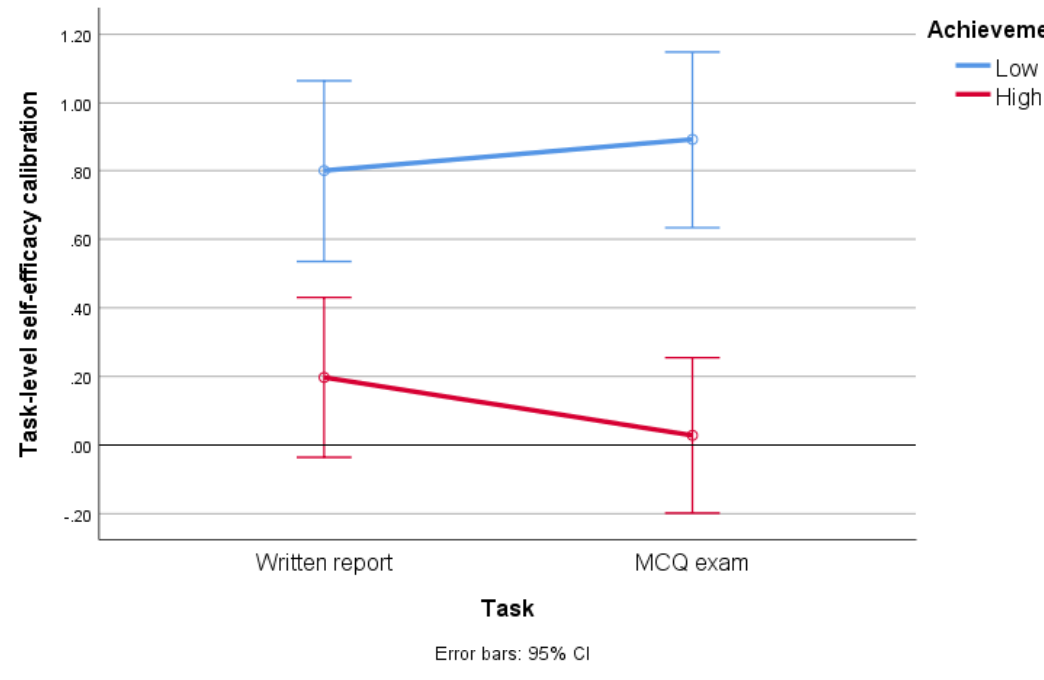
Self-efficacy Bias Across Task Type and Achievement Level